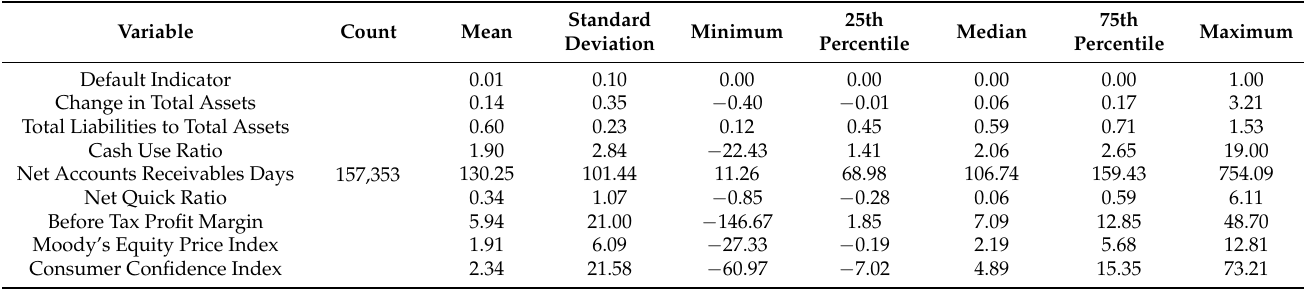
Table 3. Summary Statistics—Moody’s Large Corporate Financial and Macroeconomic Explanatory Variables and Default Indicators: 1-Year PIT Model 1. Variable Count Default